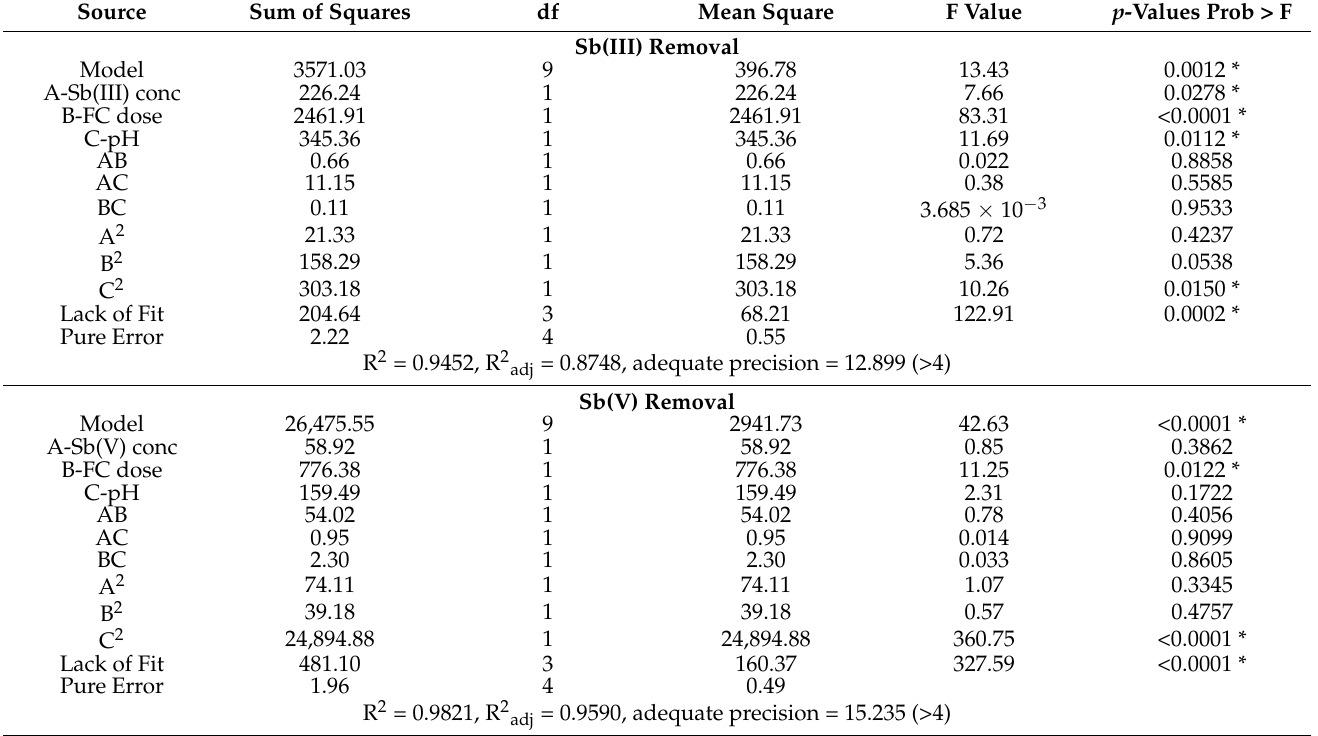
Table 6. ANOVA results for two second order responses (Sb(III) and Sb(V) removal)